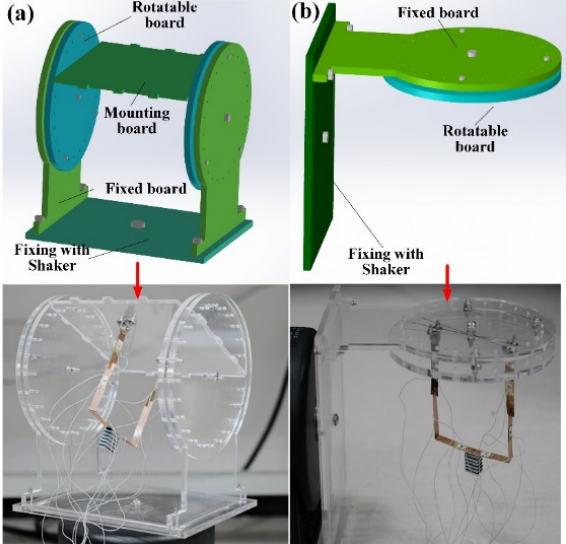
Figure 7. Tailored clampers for ( a ) vertical and ( b ) horizontal vibrations.